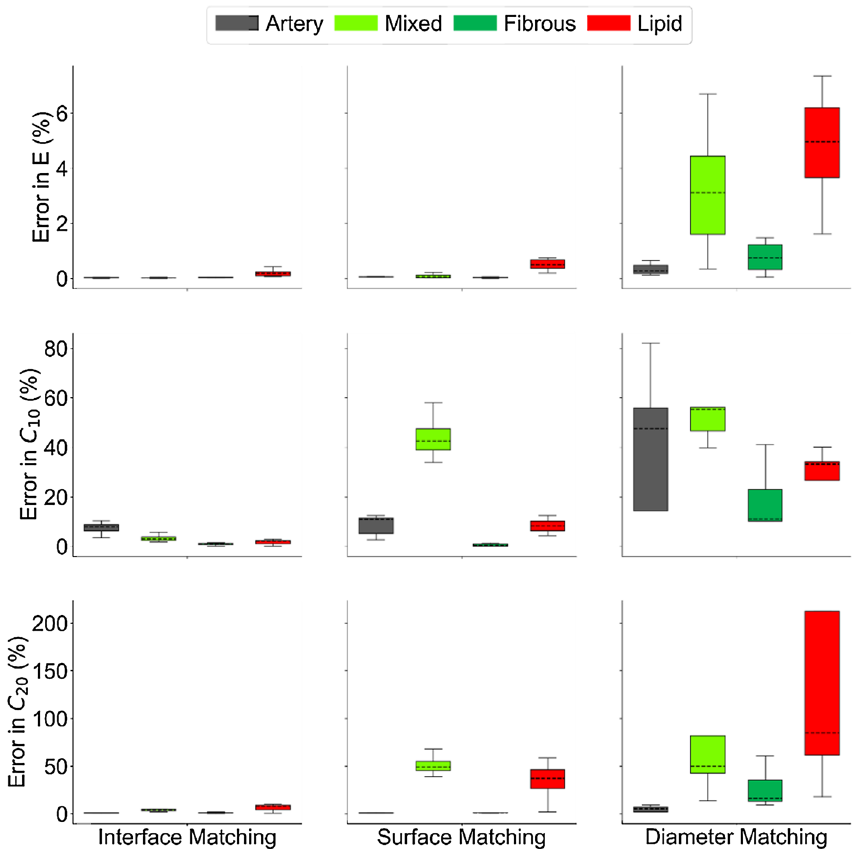
Figure 4. Errors in linear elastic (top row) and Yeoh (middle and bottom rows) material parameter recovery over 8 runs. The performance of the current interface matching method (left column) is compared to inner and outer surface matching alone (middle column), and diameter matching (right column). Full interface matching outperforms surface matching and diameter matching in all cases, but the distinction is more pronounced for the higher-order Yeoh model and for the predominantly intramural materials (mixed and lipid tissue). The median errors (dashed horizontal lines) were greater for material parameters with lower assigned value magnitudes. Boxes extend from 25th to 75th percentiles; range bars extend to extrema.